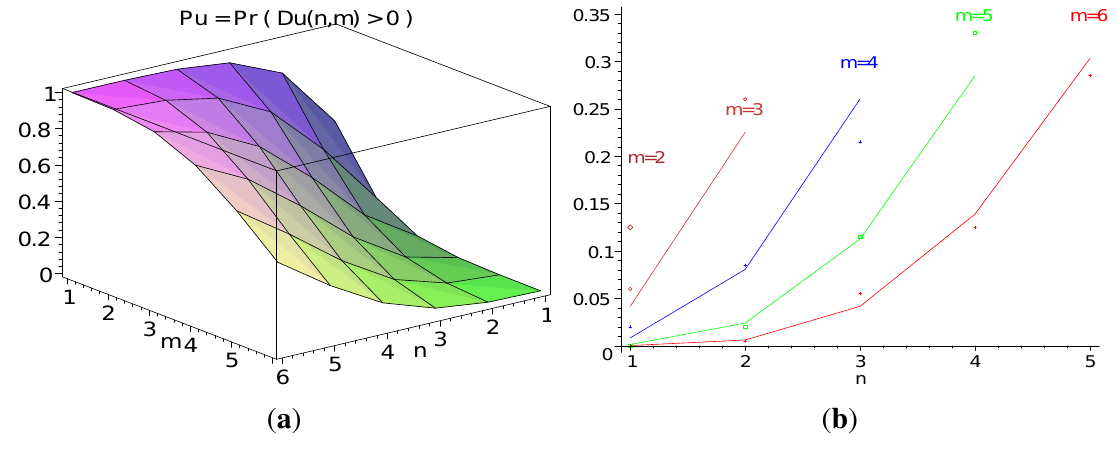
≡ P r ( D ( n,m ) > 0) , depending on ∆ = m − n > 0 , for different U U